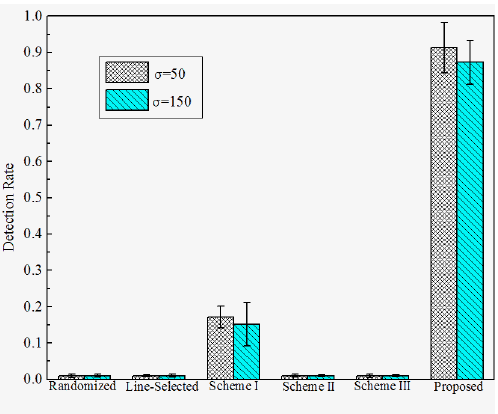
Figure 12. Detection rate of proposed versus prior works under attack strategy III when D = 200.